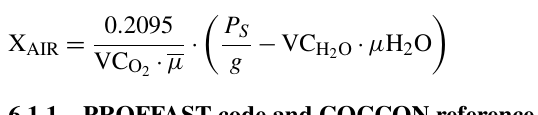
umn VC H , as given in Eq. 2 O